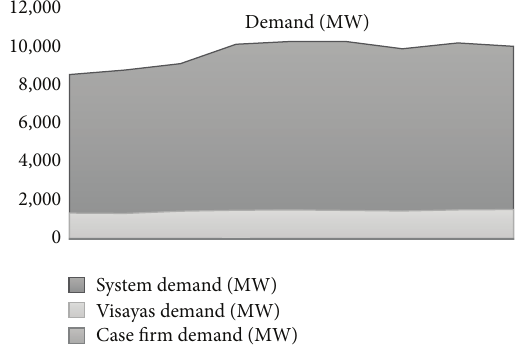
Figure 2: Demand comparison